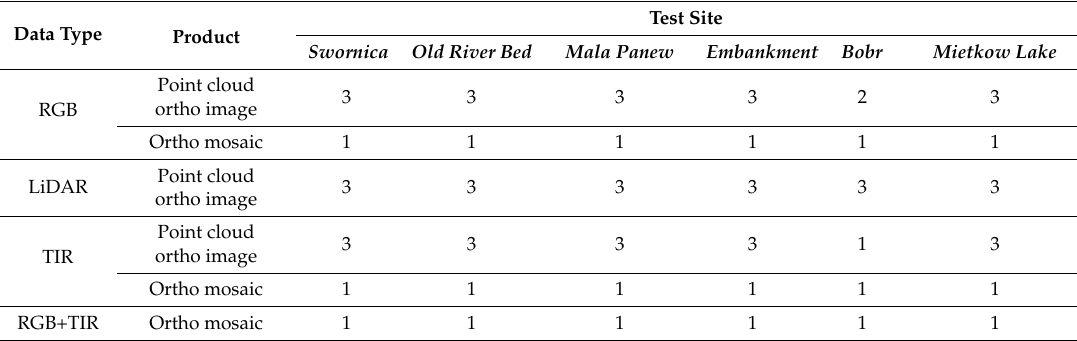
Table 4. The identification strategies selected with respect to product and test